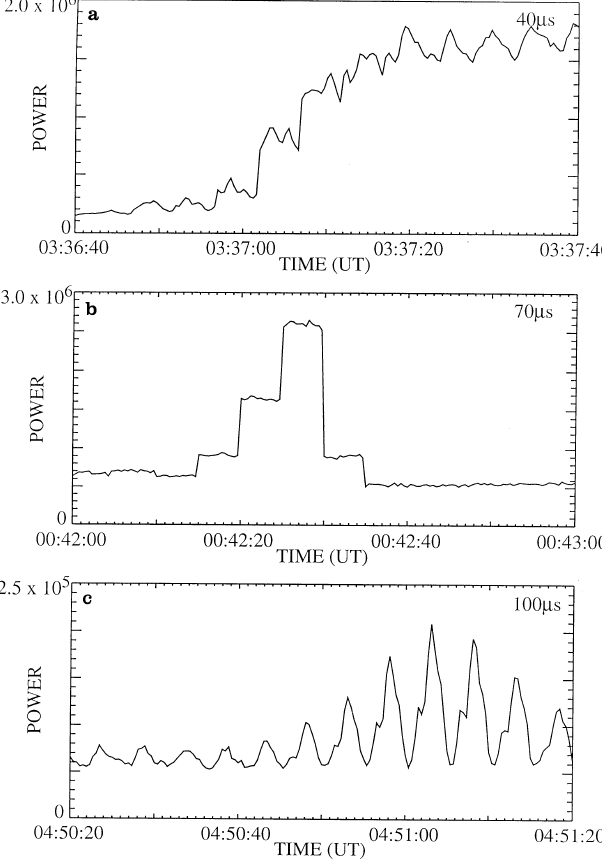
Fig. 3a–c. A comparison of observations at a 40, b 70 and c 100 (cid:108) s